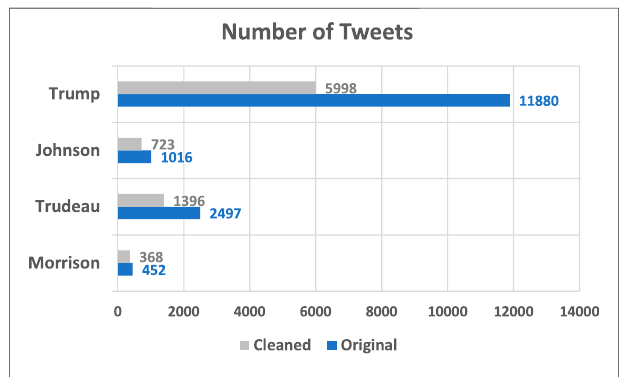
FIGURE 1 | Number of tweets.